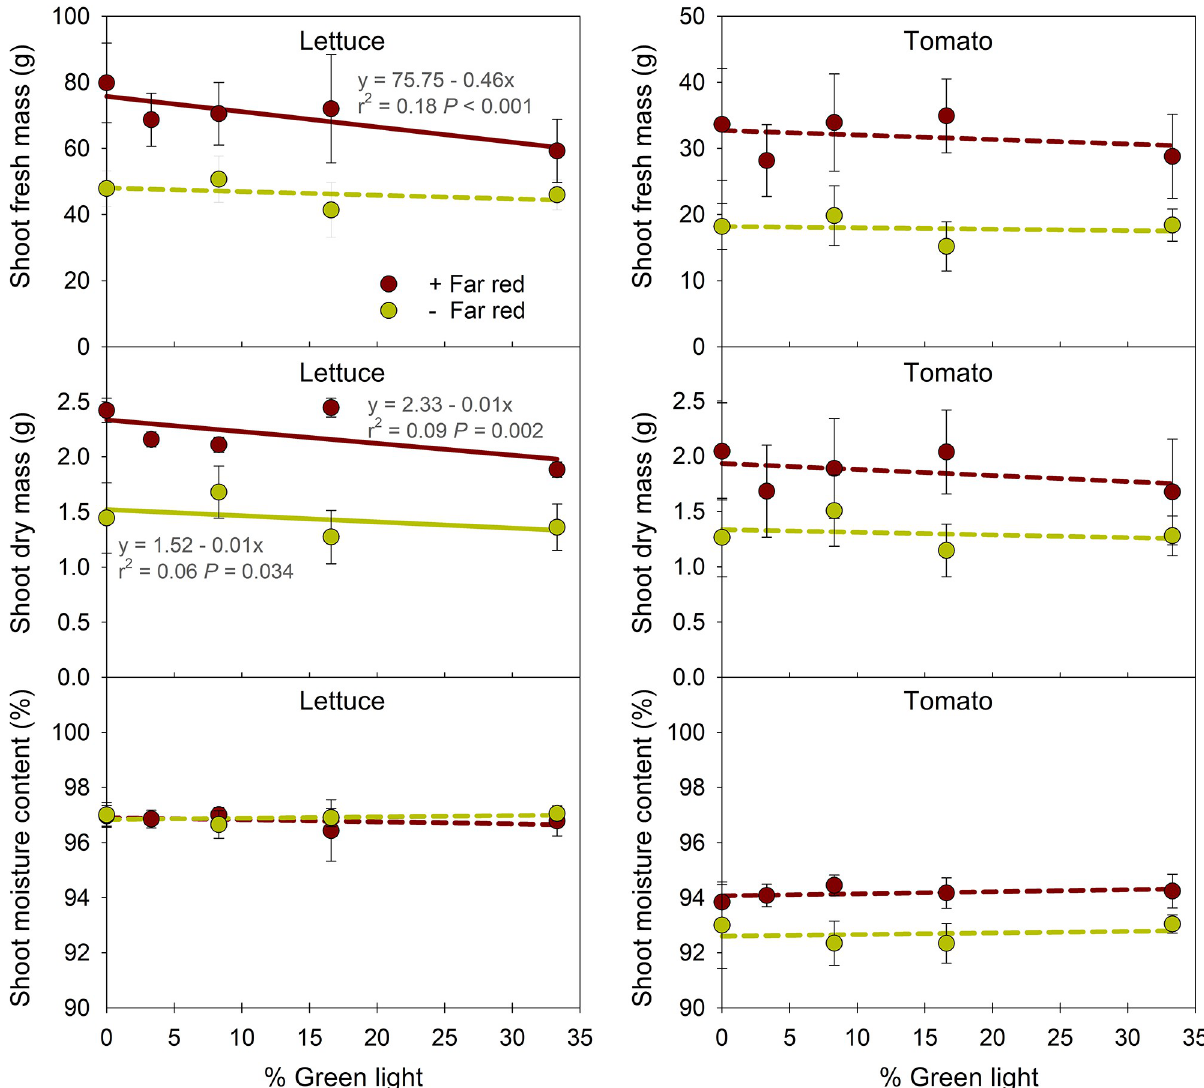
Fig 4. Influence of percentage of green light on shoot fresh mass, dry mass, and moisture content of lettuce ‘Cherokee’ and tomato ‘Bamborange’ with (+) and without (-) far-red light. See Fig 1 and Table 1 for information on the lighting treatments. Each data point represents the mean and standard deviation of two replications with 10 subsamples (plants) per replication and species (n = 20). Regression equations, r 2 values, and P values are presented when statistically significant (solid line) but not when non-significant (dashed line).